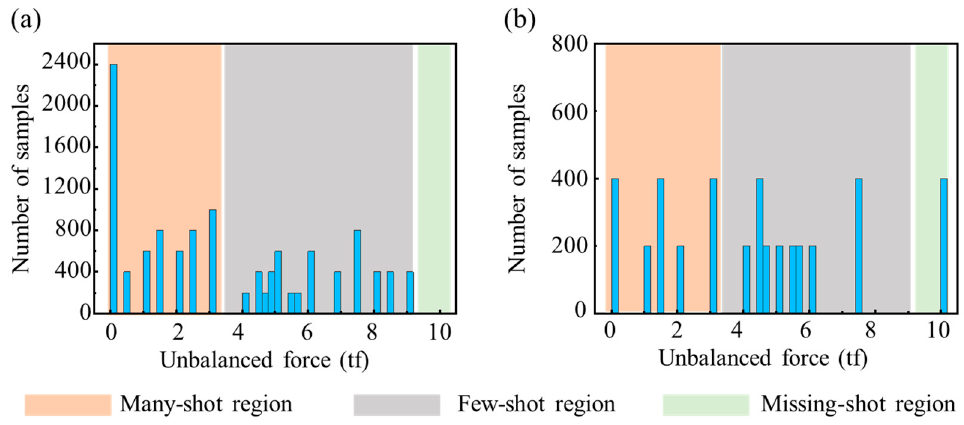
Figure 5. The distribution of the unbalanced force labels. ( a ) Training dataset. ( b ) Test dataset.